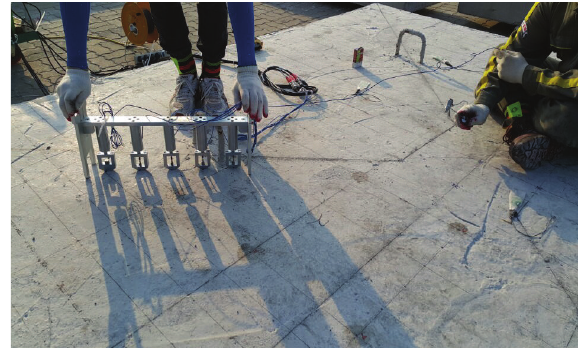
Figure 15: MASW test for the R-wave measurement along prede- fined paths on the concrete slab